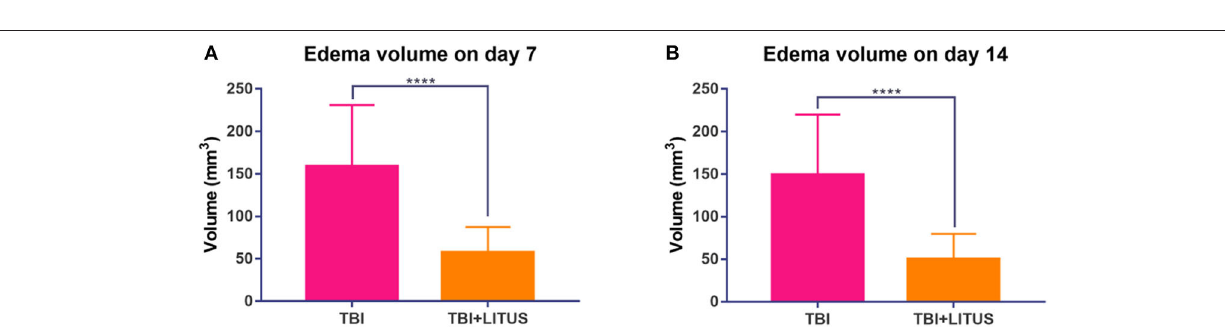
FIGURE 4 | (A) Edema volume in injury cortex on day 7. (B) Edema volume in injury cortex on day 14. Data are mean ± SD, n = 15. Unpaired t -test, **** P <